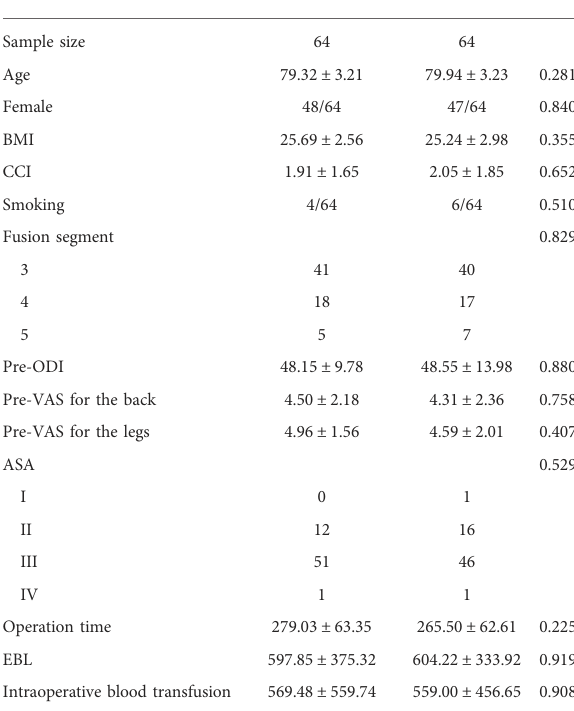
TABLE 1 Patients ’ demographics. TABLE 2 Perioperative outcomes between the enhanced recovery after surgery frail group and the non-enhanced recovery after surgery frail group.